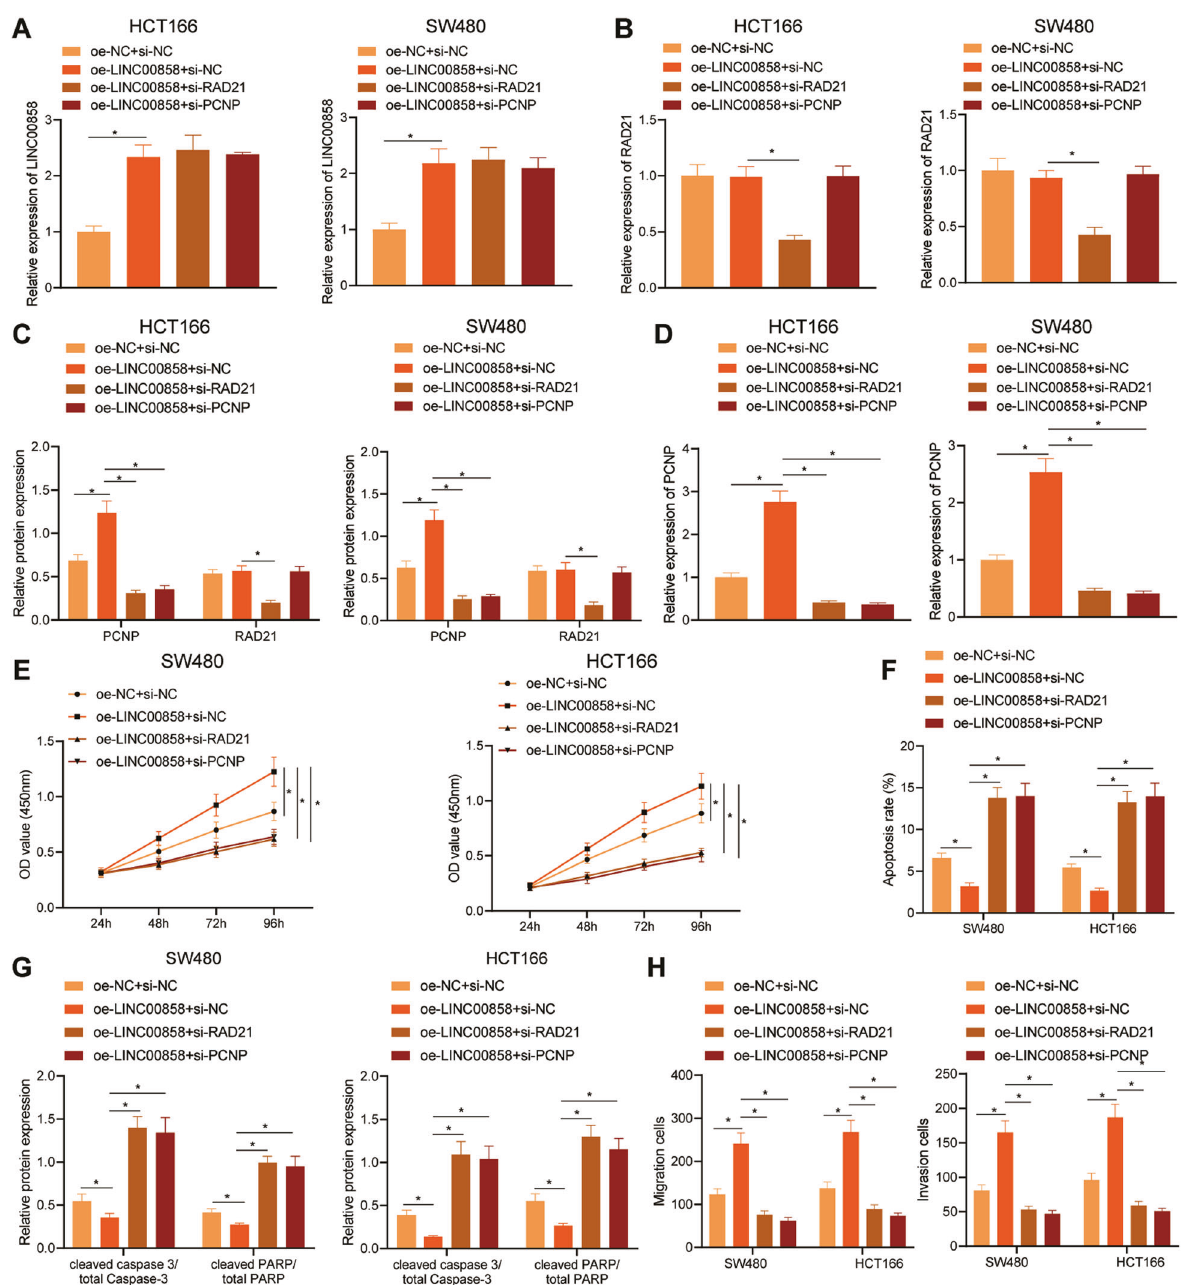
Fig. 4 LINC00858 promoted the malignant phenotype of colon cancer cells and inhibited their apoptosis by regulating the RAD21-PCNP axis. A The expression of LINC00858 in HCT166 and SW480 cells determined by RT-qPCR. B The expression of RAD21 in HCT166 and SW480 cells determined by RT-qPCR. C PCNP and RAD21 protein expression in HCT166 and SW480 cells in each group determined by Western blot assay. D Expression of PCNP in HCT166 and SW480 cells determined by RT-qPCR. E Proliferation of HCT166 and SW480 cells in each group determined by CCK-8 assay. F Apoptosis of HCT166 and SW480 cells in each group detected by fl ow cytometry. G Protein expression of cleaved caspase-3/total Caspase 3 and cleaved PARP/total PARP in HCT166 and SW480 cells in each group determined by Western blot assay. H The migration and invasion of HCT166 and SW480 cells examined by Transwell assay. * p < 0.05. Data from multiple groups were compared using one-way ANOVA with Tukey ’ s post hoc tests. Repeated measures ANOVA with Bonferroni ’ s post hoc test was used to compare data from multiple time points,. All cell experiments were repeated three times. cancer cells in vivo through regulation of the RAD21/PCNP/STAT3/ Additionally, relative to the oe-NC + sh-NC treatment, the 5 axis. volume and weight of tumor were higher after the oe- LINC00858 + sh-NC treatment. When compared with the oe- LINC00858 + sh-NC treatment, the volume and weight of tumor after treatments of oe-LINC00858 + sh-RAD21 and oe- DISCUSSION LINC00858 + sh-PCNP were lower (Fig. 6C, D). These results Colon cancer is a leading reason for cancer-related death on a indicated that LINC00858 promotes the tumorigenicity of colon global scale and has a poor survival rate at less than 10% in the Cell Death Discovery (2022)